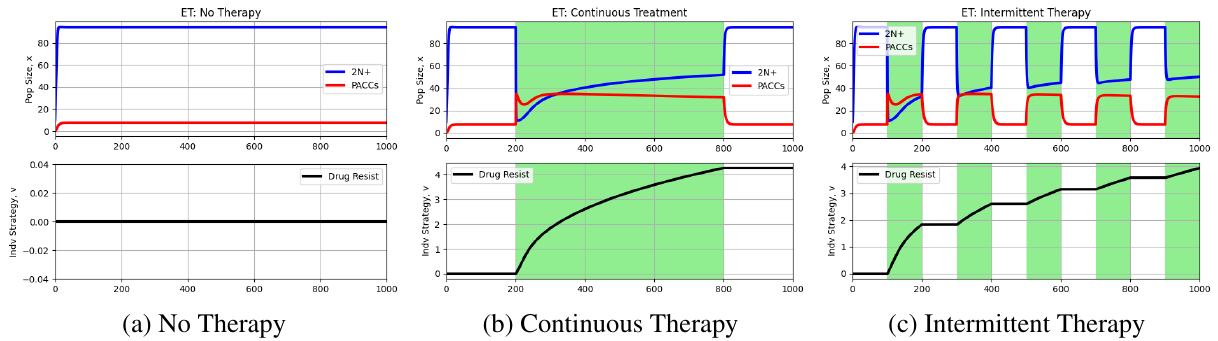
Figure 3. Simulations under evolutionary triage hypothesis. Blue and red curves depict 2N+ and PACC population dynamics, respectively, and the black curve captures the evolutionary dynamics of resistance. White and green backgrounds reflect periods without and periods with treatment, respectively. When therapy is administered, a large portion of the population switches from the 2N+ to the PACC state, avoiding the effects of therapy and increasing evolvability. As resistance emerges, the frequency of cells in the PACC state